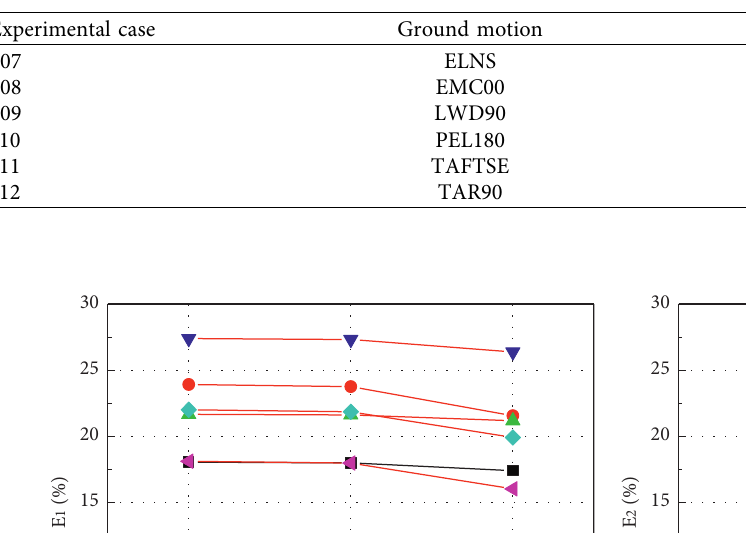
Table 7: Calculation schedule with PGA �